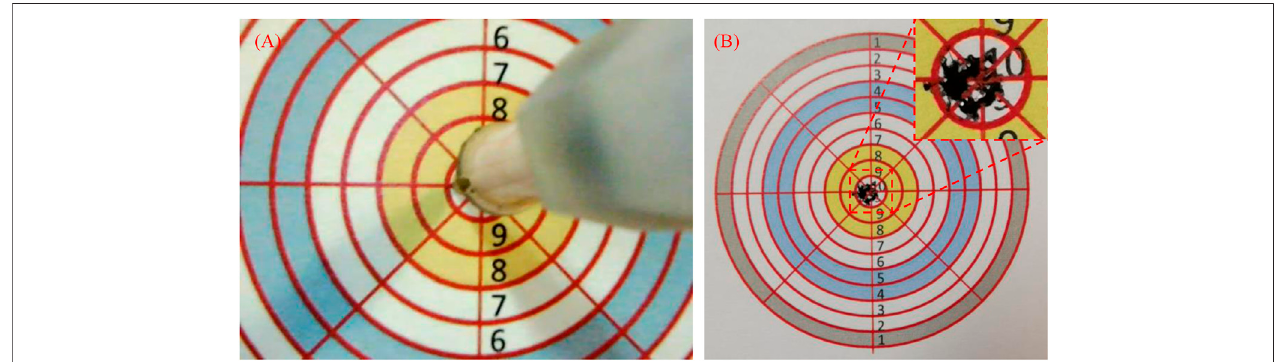
FIGURE 8 | The performance tests ’ results of the robot, (A) The fl exible manipulator was set to the initial state and put on the table, (B) The human phantom was pushed forward with the tongue contact to the tongue depressor, (C) The tongue depressor was controlled to press the tongue, (D) The fl exible manipulator was controlledtoreachtothetargetregion, (E) The fl exiblemanipulatorwascontrolledtogetsampleviatheswabstick, (F) The fl exiblemanipulatorwascontrolledtoretrieve from the throat, (G) The tongue depressor was retrieved, (H) The human phantom was pulled back.